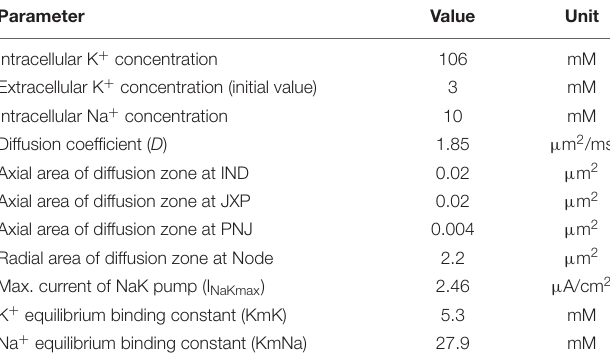
TABLE 3 | Parameters for modeling dynamics of K +